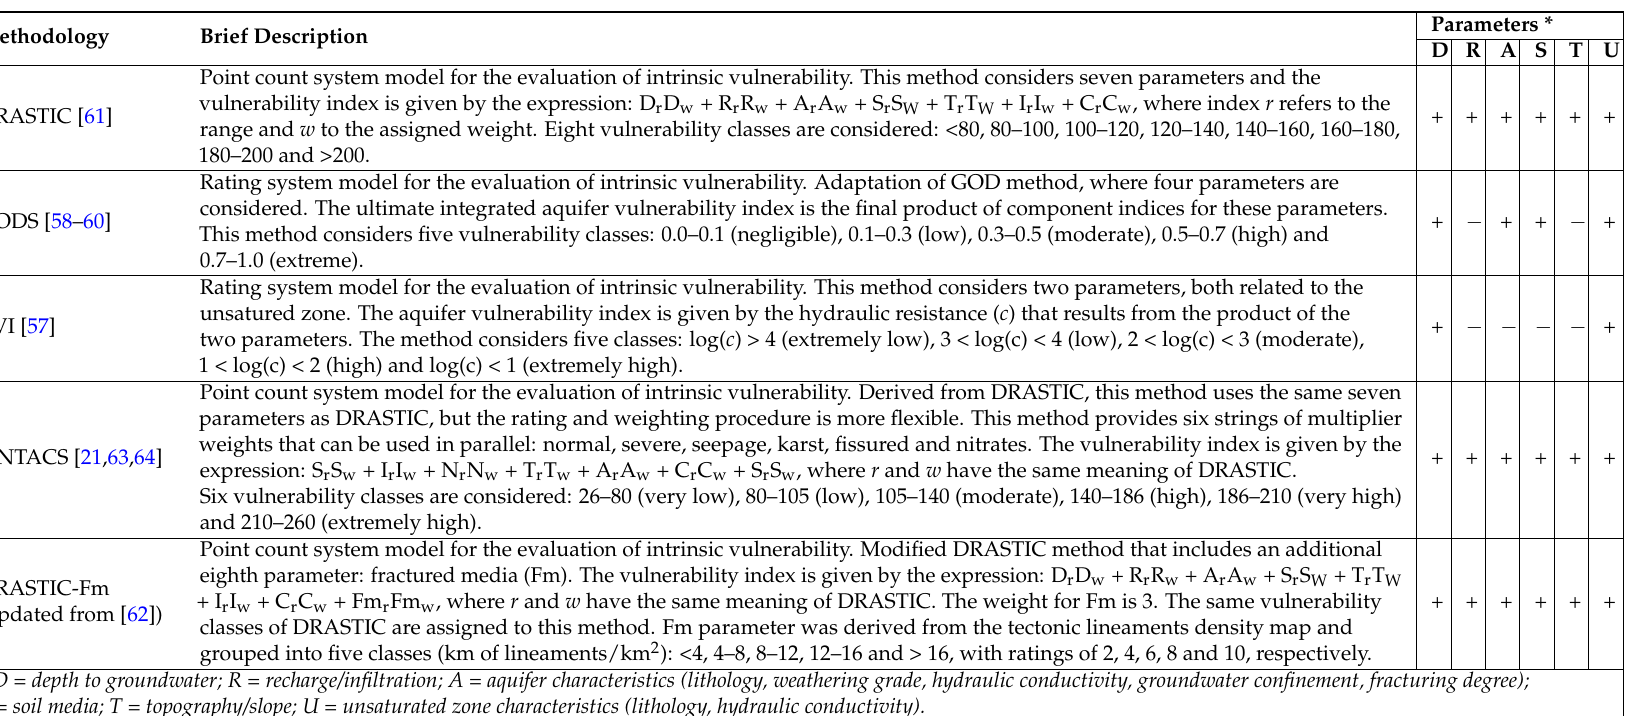
Table 1. Selected index vulnerability mapping methods to fissured